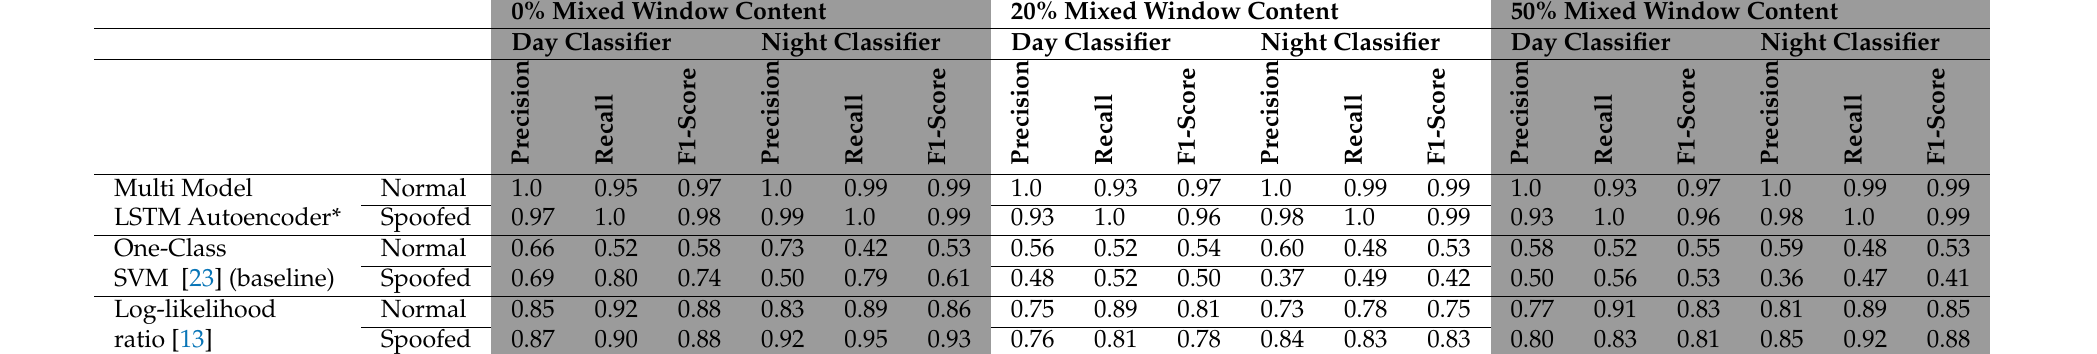
Table 2. Passive Adversary, who assumes a single spot in the environment and does not adjust its transmission